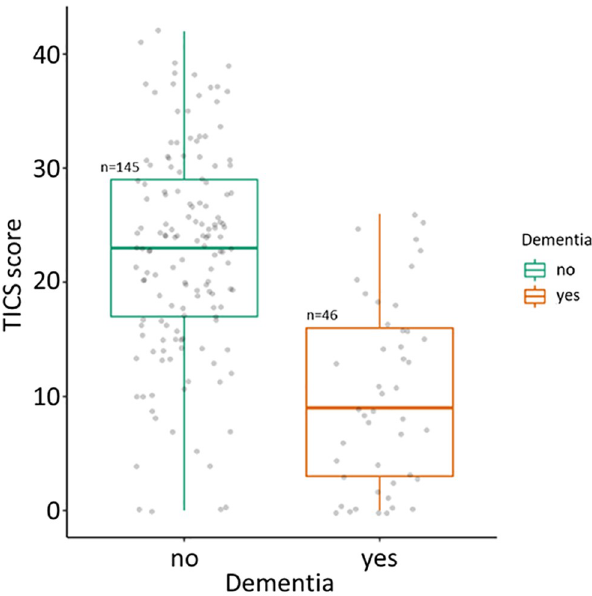
Fig 2. Cognitive performance in TICS by dementia